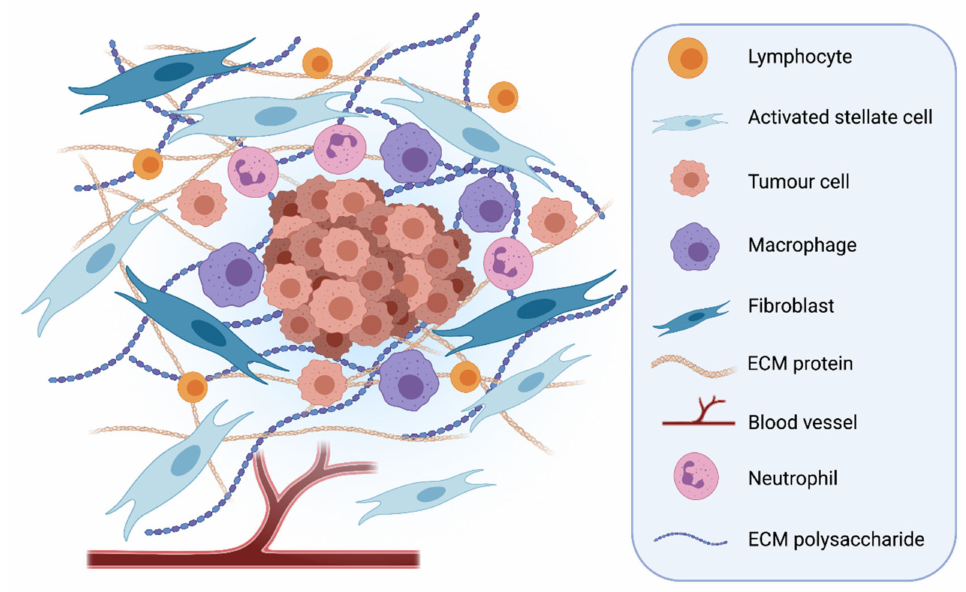
Figure 1. Desmoplastic stroma in Pancreatic Ductal Adenocarcinoma. The stroma makes up a large volume of PDAC tumours. Many cells found within the stroma can contribute to tumour progression and invasion, such as activated pancreatic stellate cells, inflammatory immune cells and cancer associated fibroblasts. The stroma is very stiff due to the high levels of Extracellular Matrix (ECM) proteins that are laid down by activated stellate cells and fibroblasts. PDAC tumours are hypoxic and do not contain many blood vessels [14]. Created with